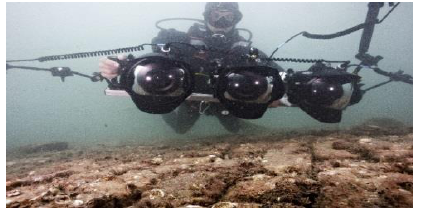
Figure 7. Underwater survey made with three digital cameras associated and synchronized on a rigid bar. (Photo P.